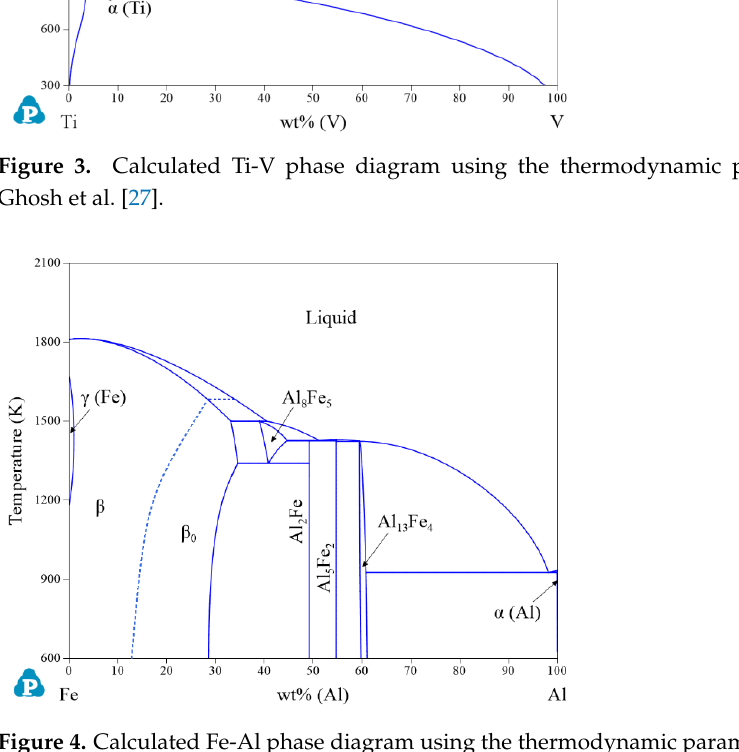
Figure 4. Calculated Fe-Al phase diagram using the thermodynamic parameters obtained by Sundman et al. [30].